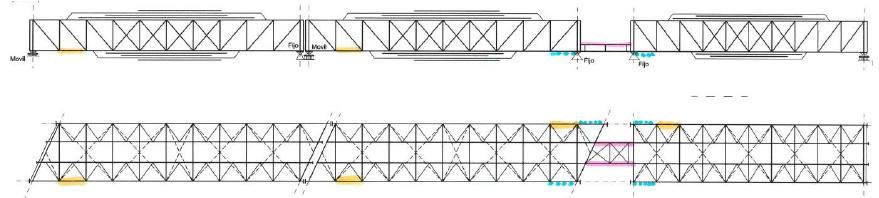
Figure 6. “Bembézar” sampling sketch. Yellow: bottom chord of the main beam, Blue: bottom chord of external beams on the 2nd pile, Pink: stringers on the 2nd pile.